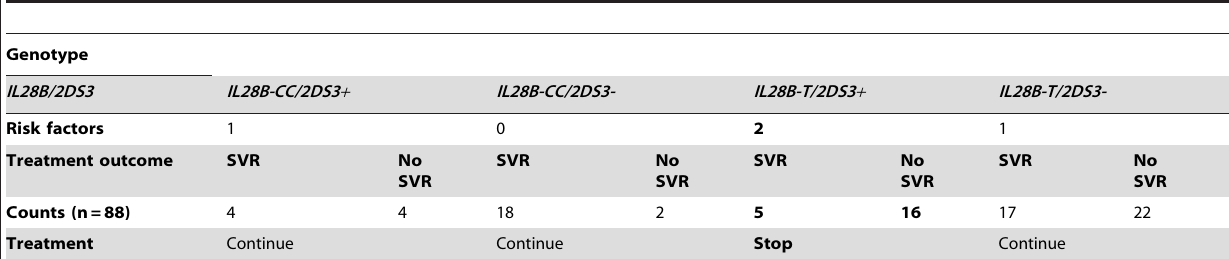
Table 6. Presence of host genetic risk factors identifies RVR negative patients that will fail to achieve SVR on completion of